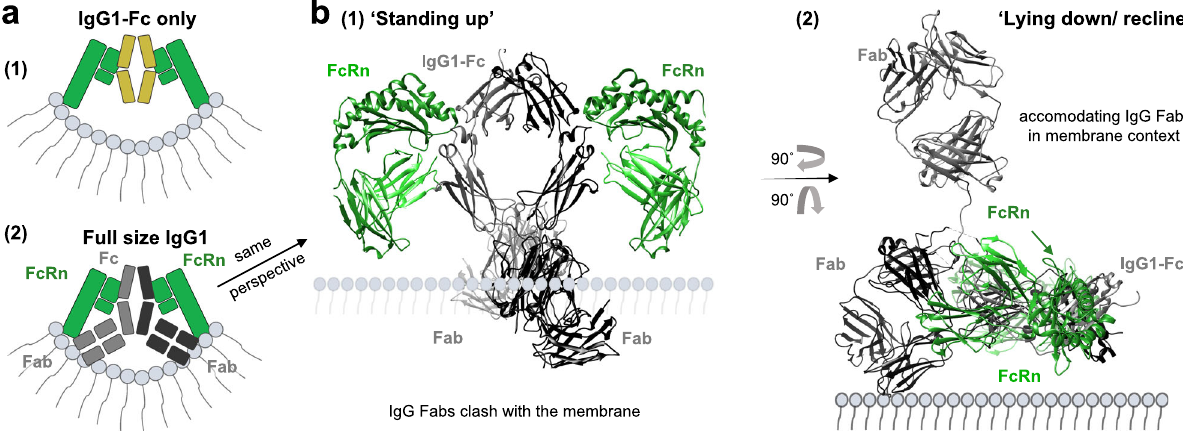
Fig.6|IgG-FabarmscauseasterichindrancewhenIgGisboundtomembrane- associated FcRn. a Graphical illustration of potential steric hindrance caused by the Fab arms when anIgGbinds membrane-associated FcRn. b Crystalstructureof FcRnboundtoIgGinamembranecontextinthesame “ standingup ” conformation